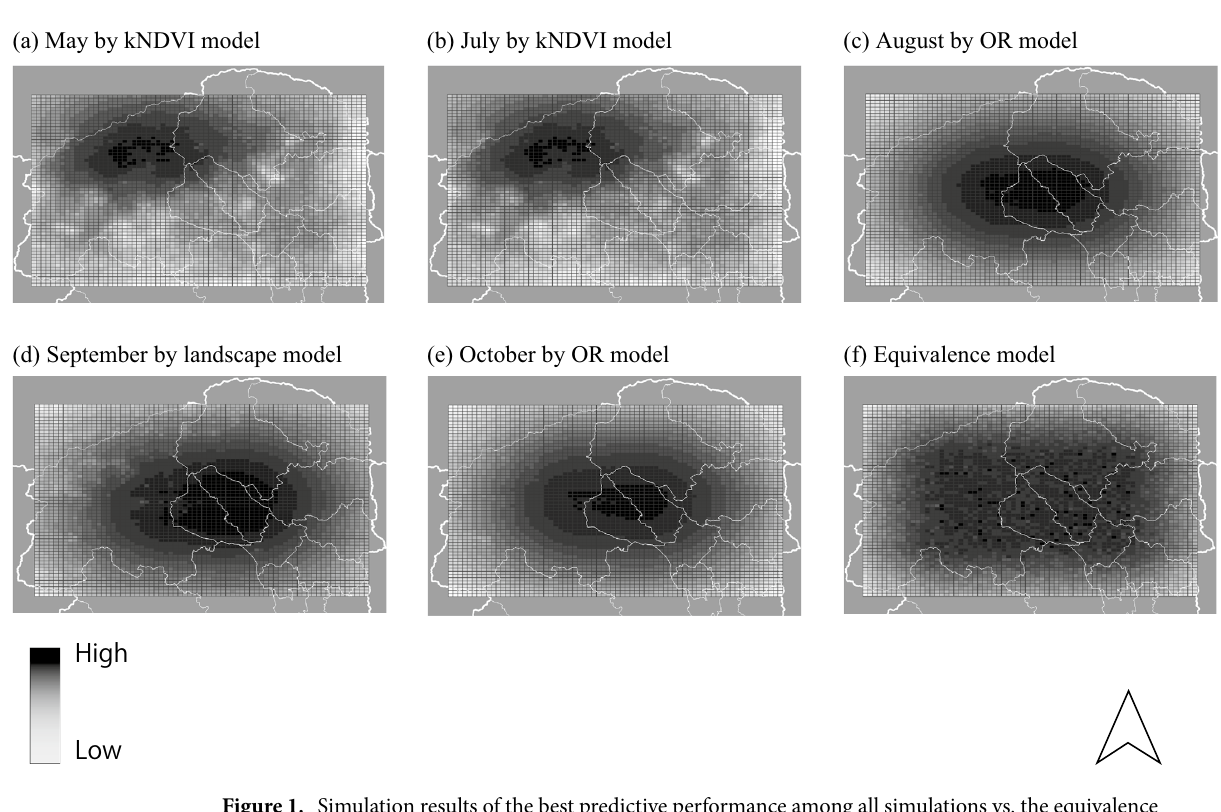
Figure 1. Simulation results of the best predictive performance among all simulations vs. the equivalence model. Deep black indicates a high frequency of visits by the virtual population. Local governmental borders are indicated by white lines. The results of June and November are not shown because the simulation model could not predict the movements of sika deer during these